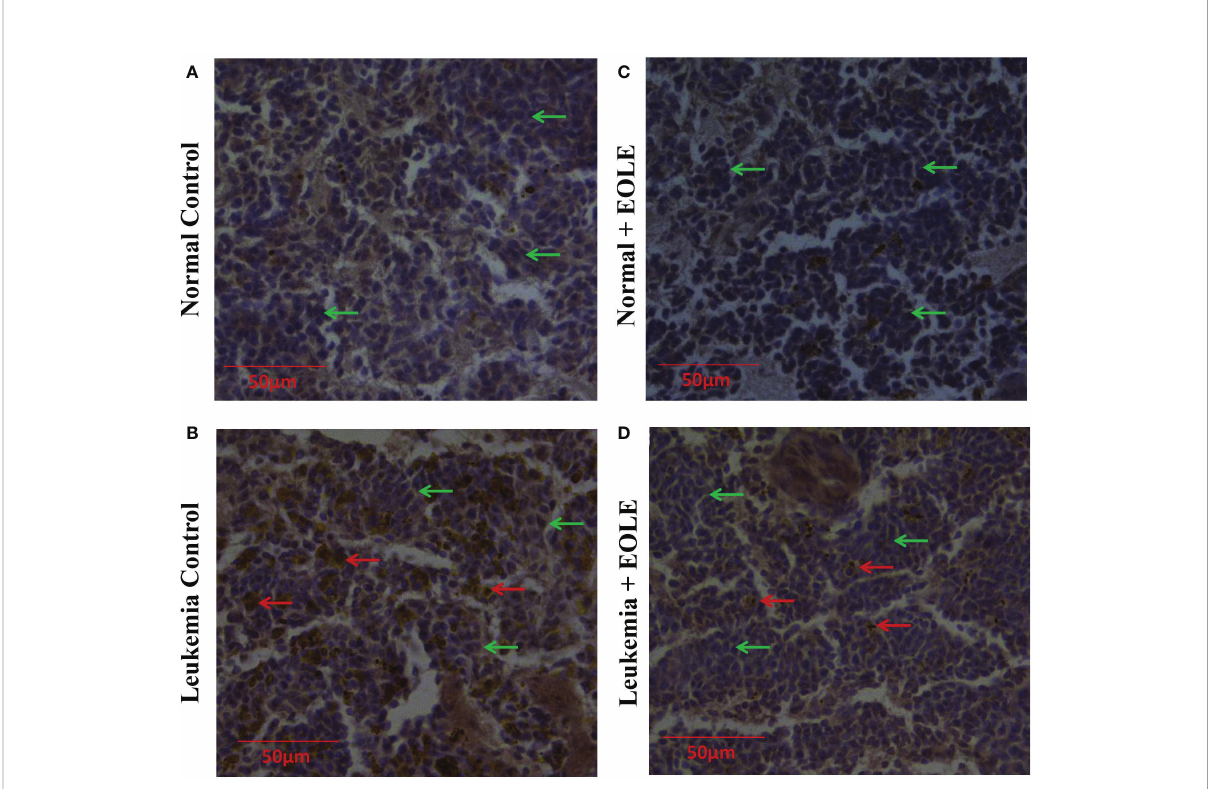
FIGURE 9 Immunohistochemistry images of splenic sections for BCLA1 protein. (A) Normal control, (B) Leukemia control, (C) Normal + EOLE, (D) Leukemia + EOLE. In these fi gures, the brown spots indicate the intensity of BCLA1. The red arrow indicates the BCL2A1positive leukemic blast cells in the spleen, and the green arrow indicates the BCL2A1 negative spleen